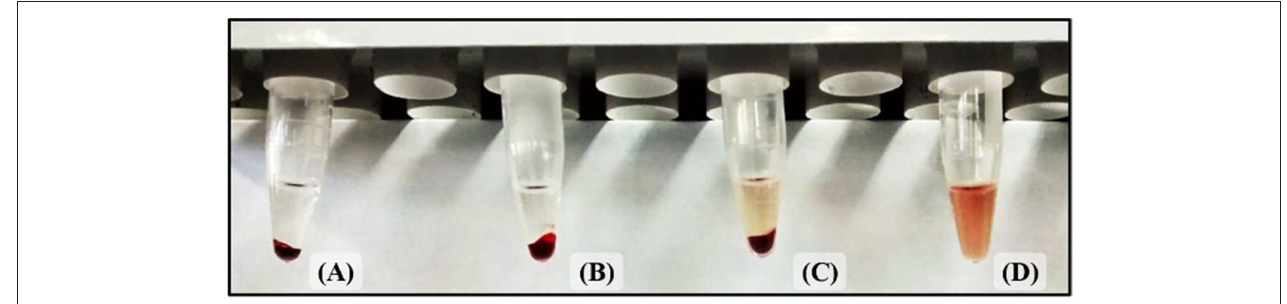
FIGURE 10 | Increase in hemoglobin concentration due to hemolysis. (A) Negative control (atoxic). (B) Low hemolysis level. (C) High hemolysis level. (D) Positive control (toxic).